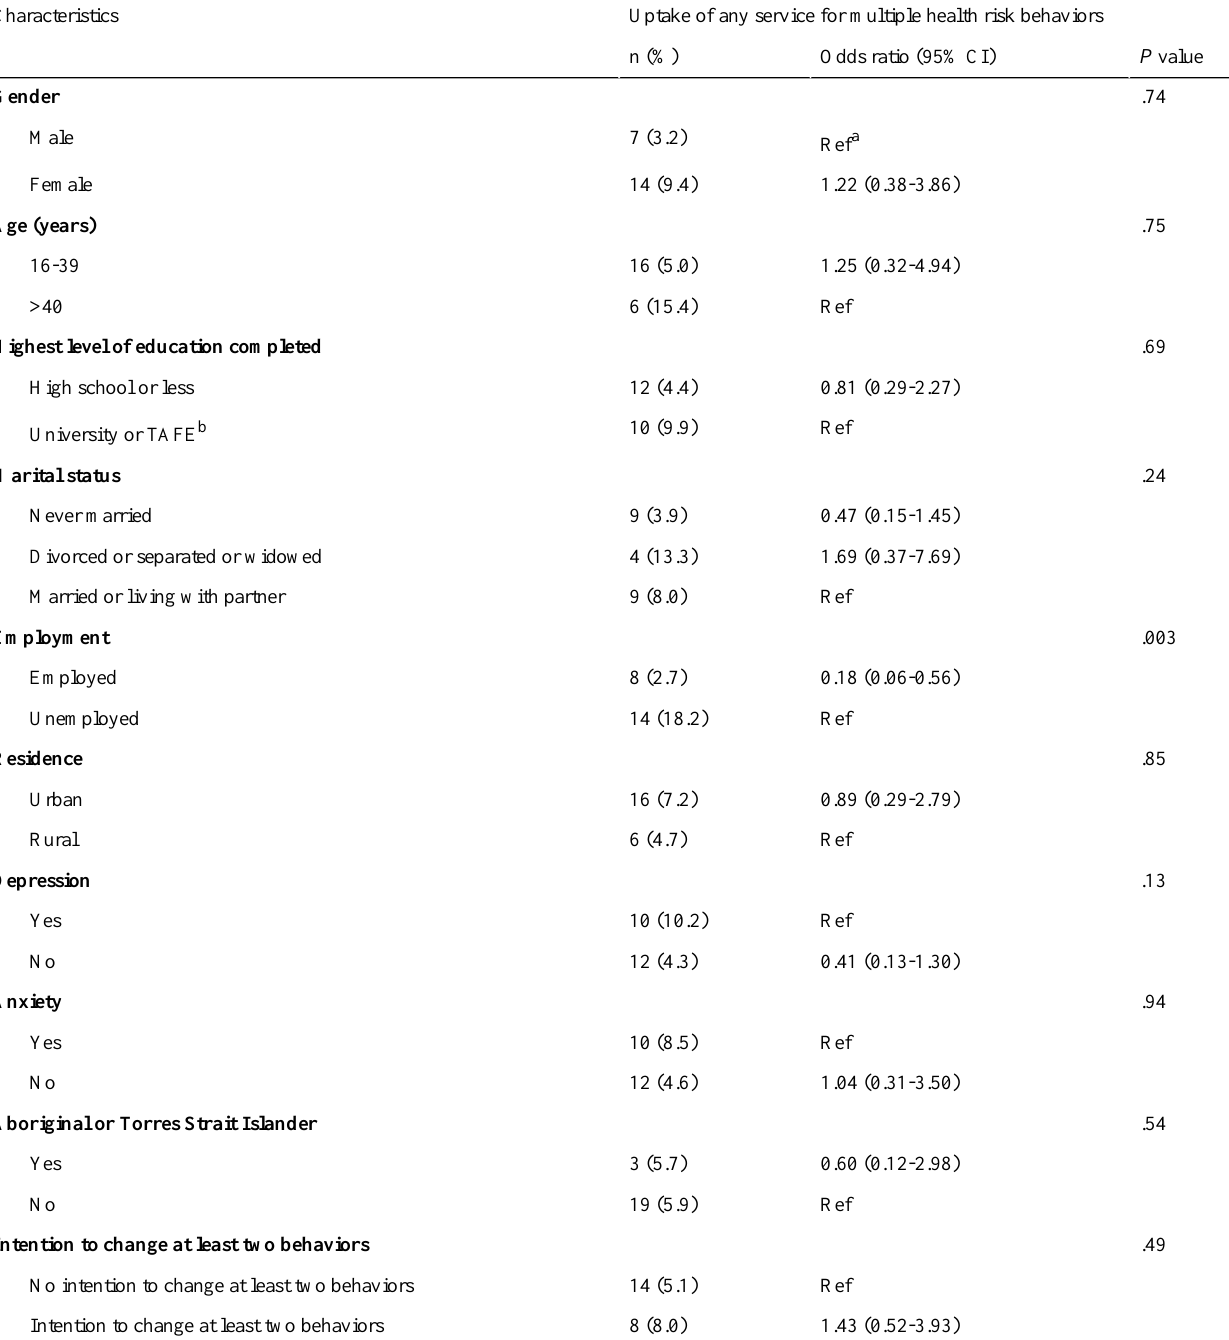
Table 6. Characteristics associated with the uptake of telephone or online support services for multiple health risk behaviors. Uptake of any service for multiple health risk